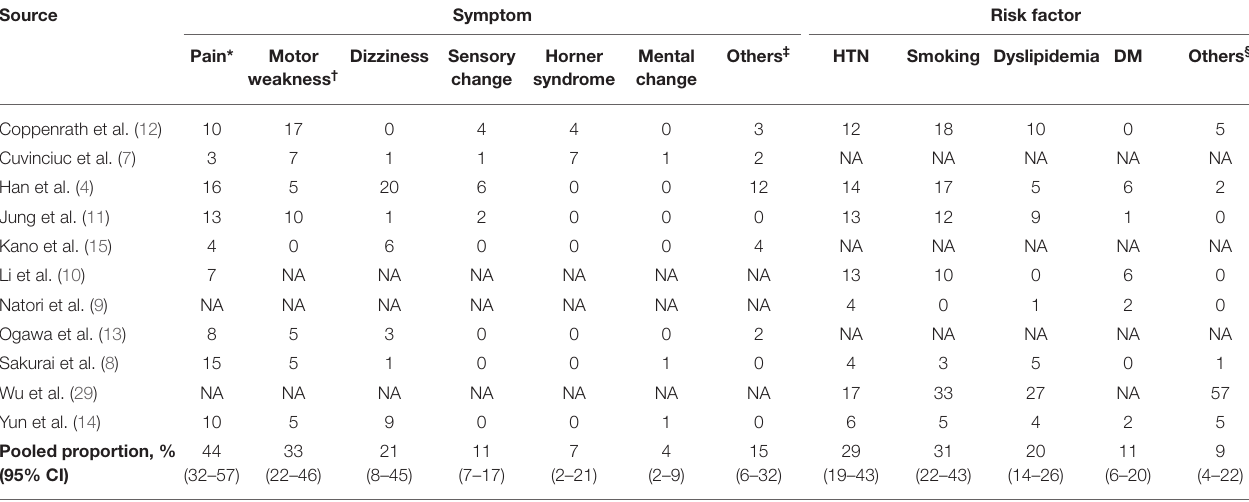
TABLE 2 | Pooled proportion of symptoms at presentation and the risk factors of patients with arterial dissection. Source Symptom Risk factor Dizziness Sensory Horner Mental Others ‡ HTN Smoking Dyslipidemia DM Others Pain* Motor change syndrome change weakness †